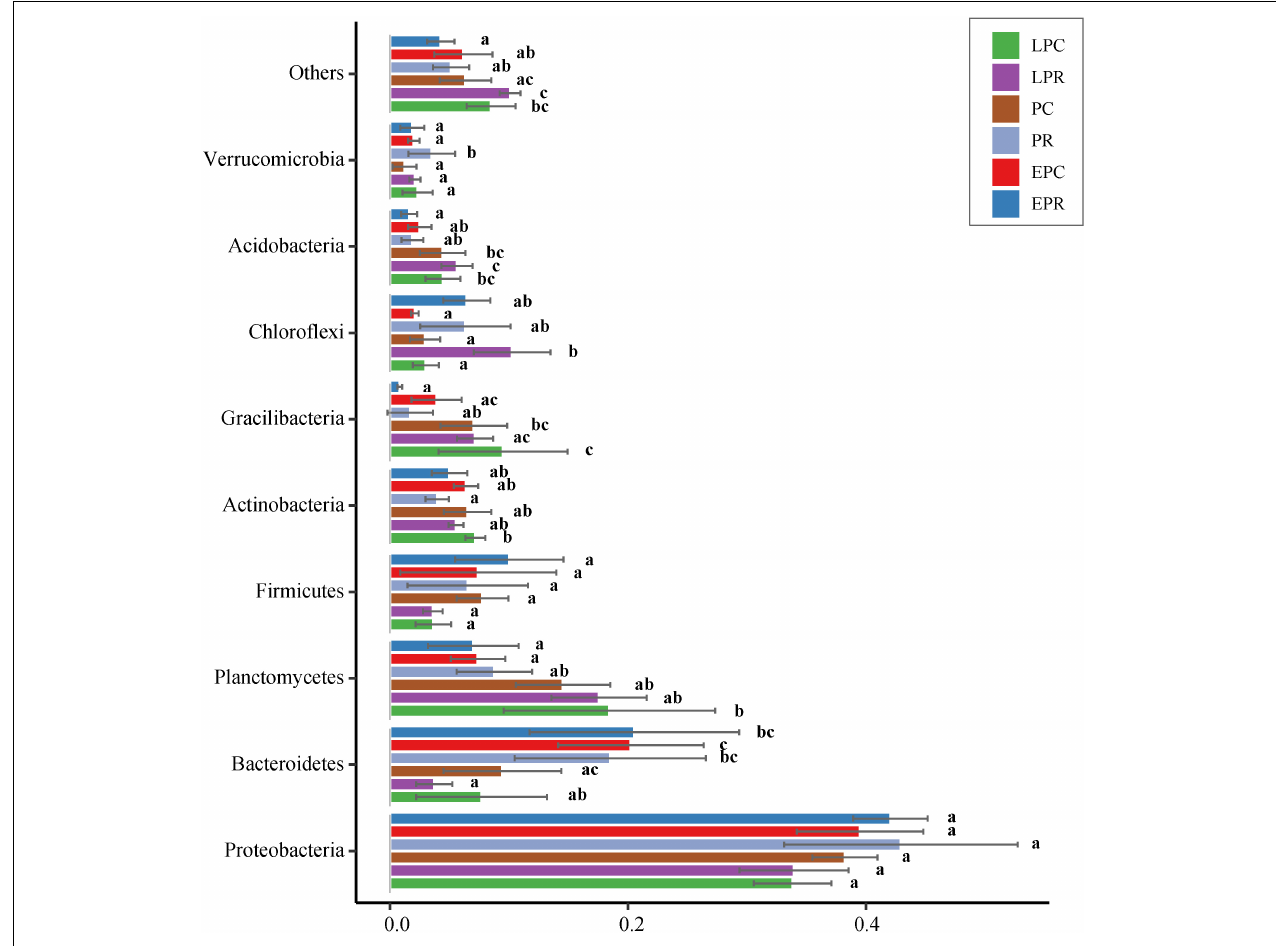
FIGURE 3 | Bar plots of the top 9 phyla abundances during different restoration periods in the degraded and non-degraded wetland. a , b , c The different letters represent the significant difference ( p < 0.05) between different